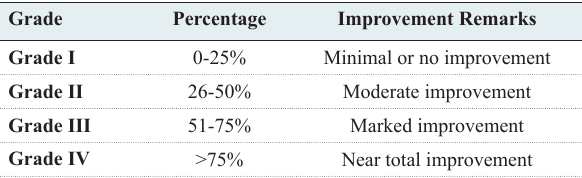
Table 1. Grade of improvement treated with Fractional ablative car- bondioxide laser resurfacing for acne scars 10 population.Grade Table 2: Number of laser procedures and percentage of scar